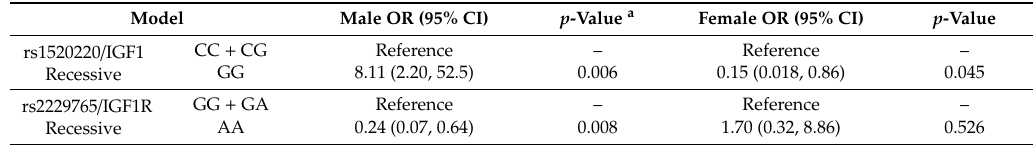
Table 6. Associations of IGF1 rs1520220 and IGF1R rs2229765 with melanoma risk in two gender strata in the GEM